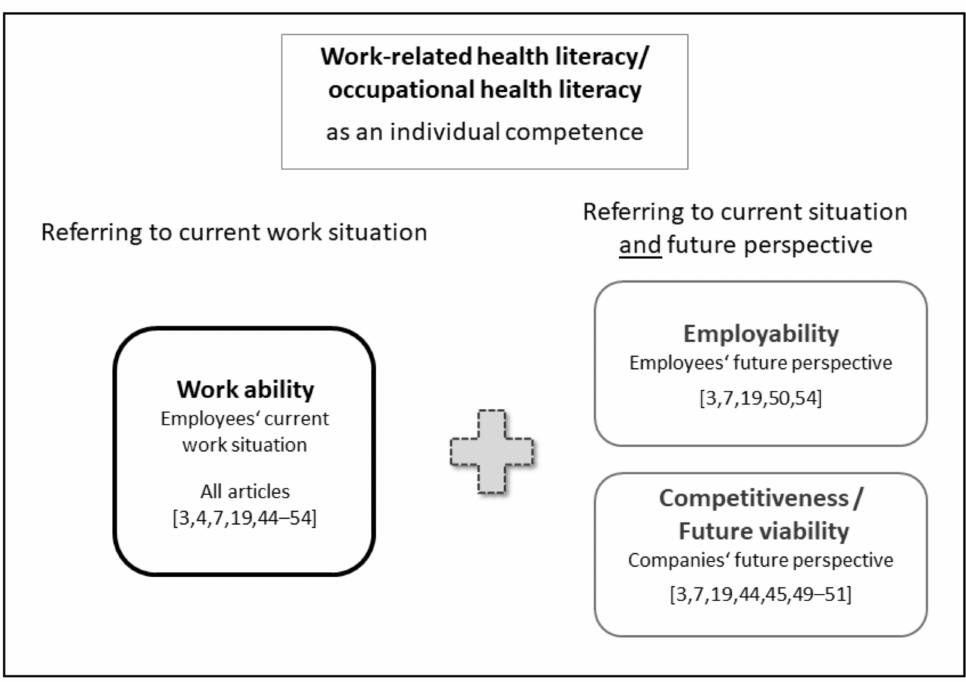
Figure 2. Possible subjects of the concept “individual work-related health literacy” (“occupational health literacy”)—research question